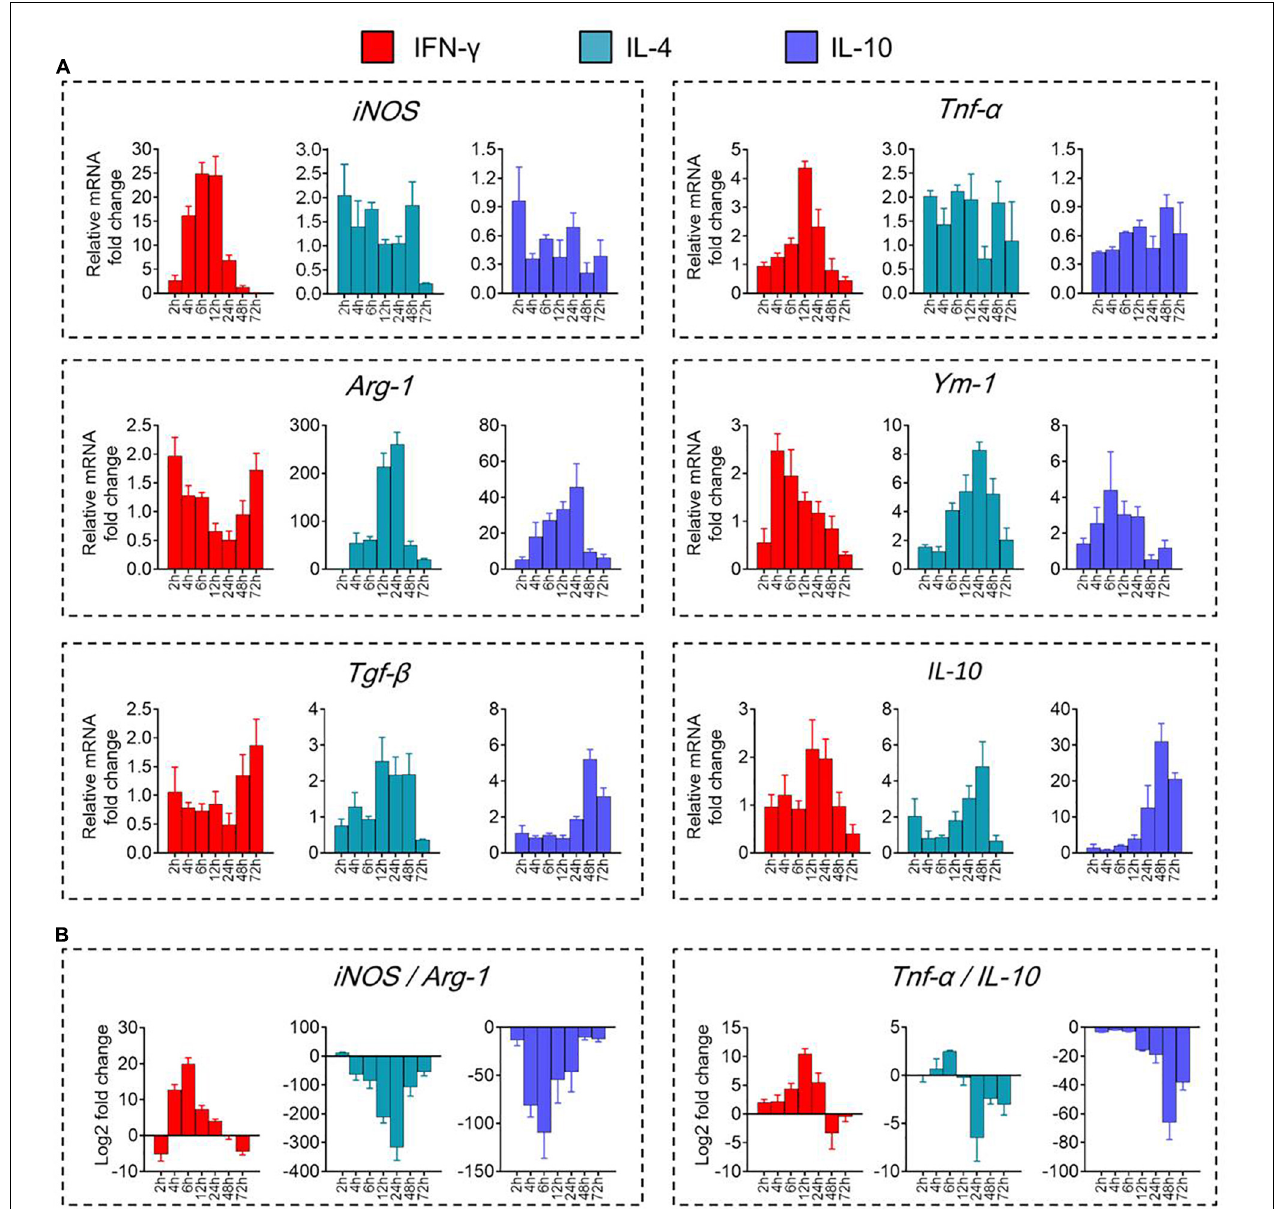
FIGURE 2 | Transcriptional definitions of microglial phenotypes induced by IFN- γ , IL-4, or IL-10. (A) Levels of mRNAs encoding iNOS, TNF- α , Arg-1, Ym-1, Tgf- β , or IL-10 following treatment with each cytokine for 2–72 h. (B) Ratios of potential marker mRNAs differentiating the three microglial phenotypes: iNOS/Arg-1 and TNF- α /IL-10. Data are presented as mean ± SEM ( n = 4–6 well per group, three replicates per